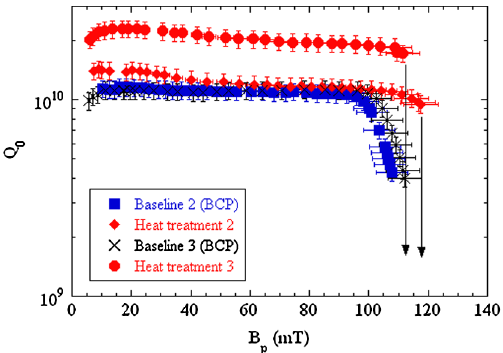
FIG. 14. (Color) Q vs B measured at 2.0 K on a large-grain p 0 CEBAF single-cell cavity after two cycles of tests consisting of a baseline, established with BCP, and a heat treatment. ‘‘Heat treatment 2’’ consisted of the same process shown in Fig. 12 with the addition of holding the furnace at 120 (cid:1) C = 6 h before final cooldown to room temperature. ‘‘Heat treatment 3’’ con- sisted of the same process shown in Fig. 12 but without N 2 injection.